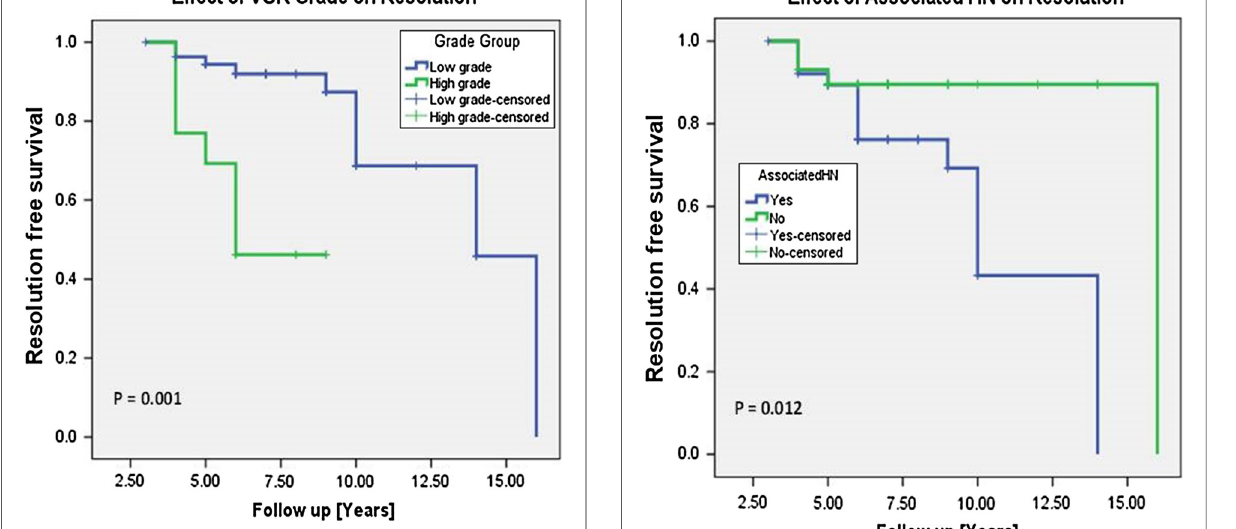
Fig. 1 Kaplan–Meier curve showing the incidence of VUR resolution stratifying by the grade of VUR